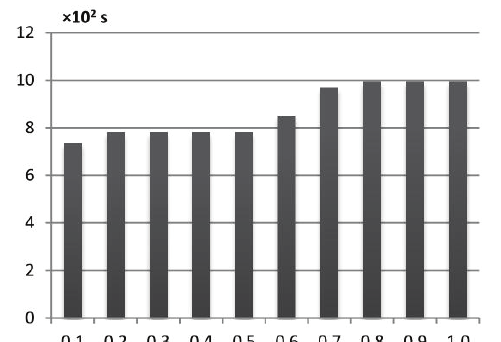
Fig. 9. The impact of α on the time of 80 queries in sec- onds on partial model with Apache Hive